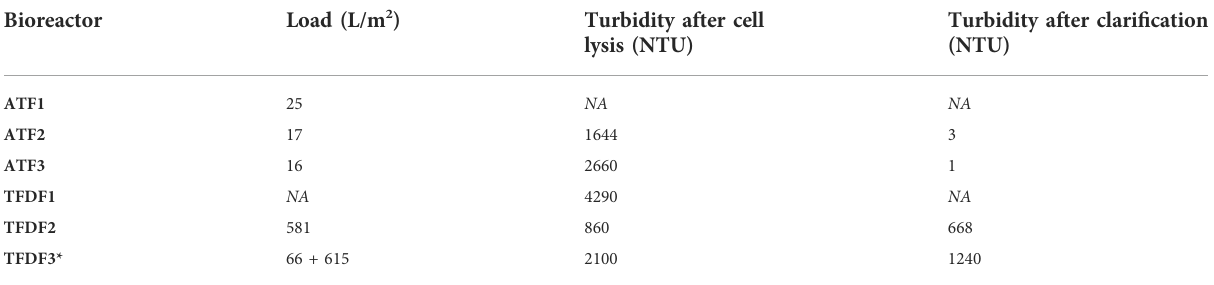
Turbidity after clari fi cation was measured after ATF, or TFDF, fi ltration. NA, not available (sample too turbid for measurement). *Two fi lters were used in these experiments; each value corresponds to the throughput of each fi lter.